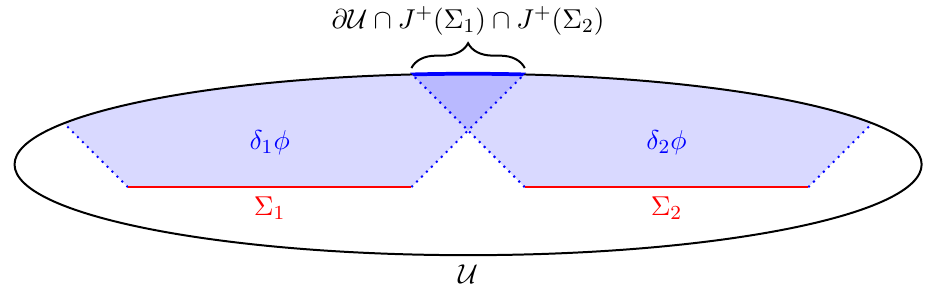
Figure 5 . The joint support of (cid:14) 1 (cid:30); (cid:14) 2 (cid:30) on @ U is contained in @ U \ J + ((cid:6) 1 ) \ J + ((cid:6) 2 ). R If one assumes that (cid:10) = ! , then the gauge transformation corresponding to (cid:21) is (cid:6)